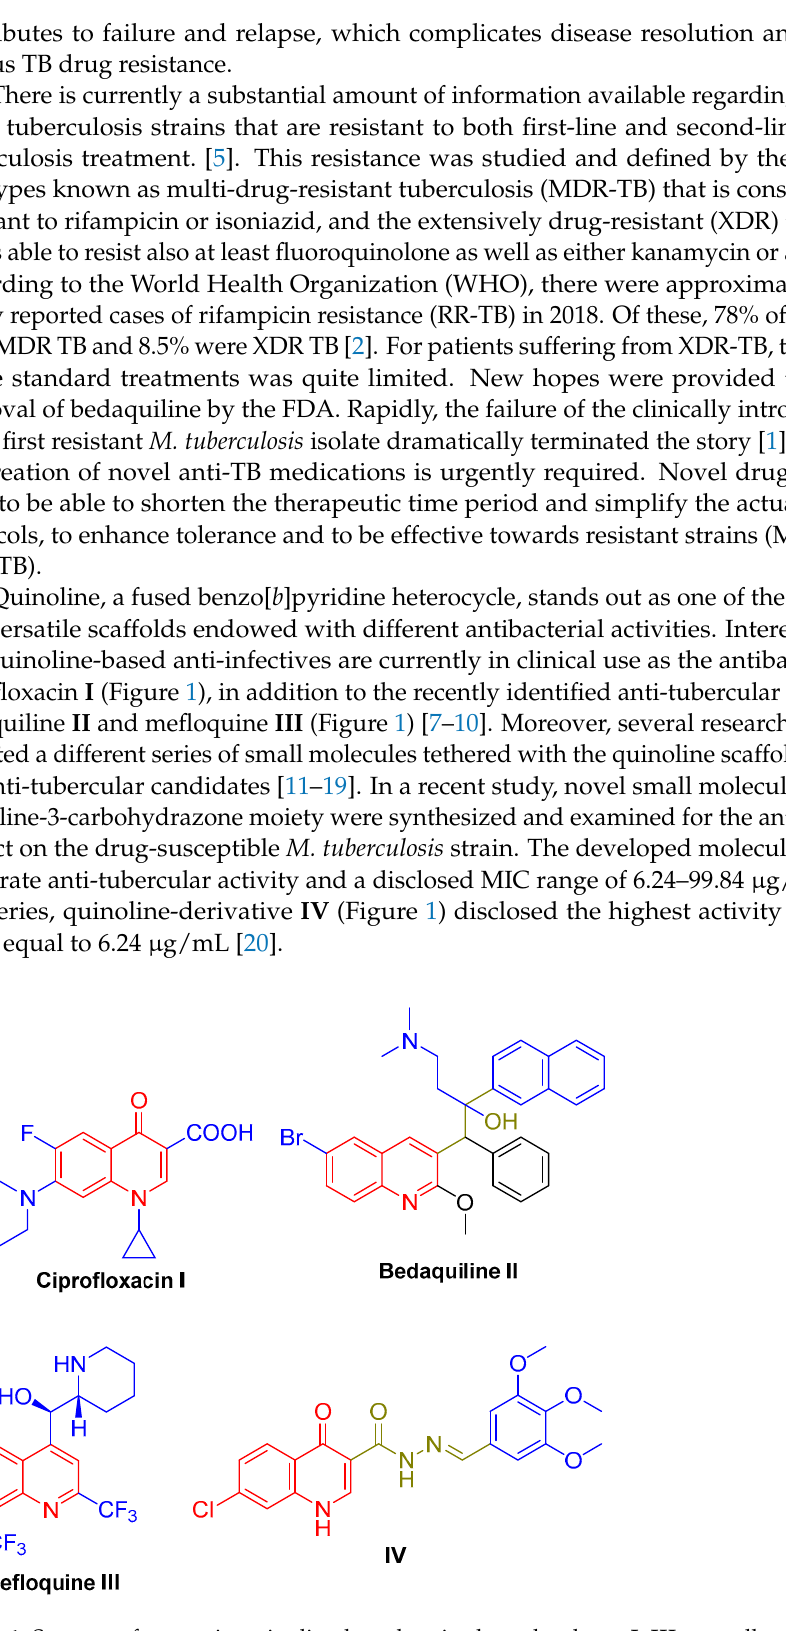
Figure 1. Structure for certain quinoline-based anti-tubercular drugs I – III , as well as the lead anti-tubercular compound IV.